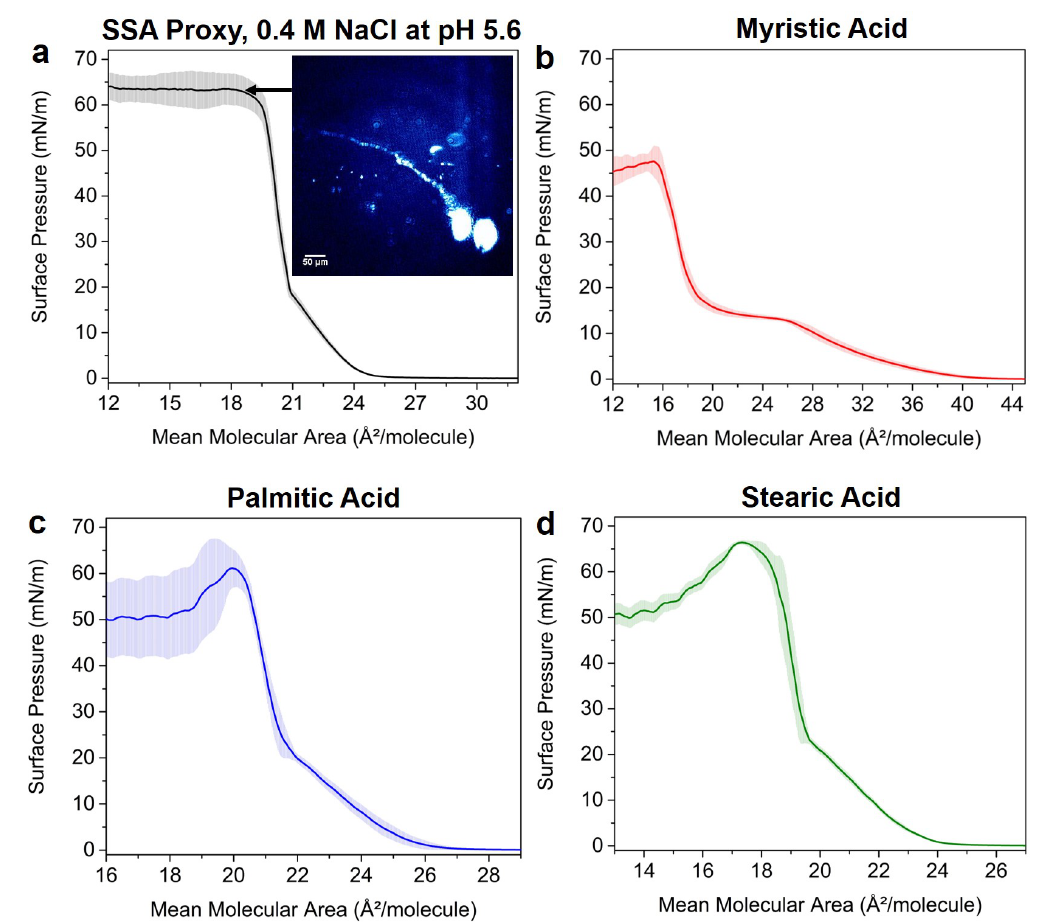
Figure 2. Π − A isotherms of the SSA proxy film and its individual components at pH 5.6: ( a ) SSA proxy film and a BAM image of the monolayer collapse, ( b ) myristic acid (MA), ( c ) palmitic acid (PA), and ( d ) stearic acid (SA). The BAM image scale bar is 50 µ m (see Supplementary